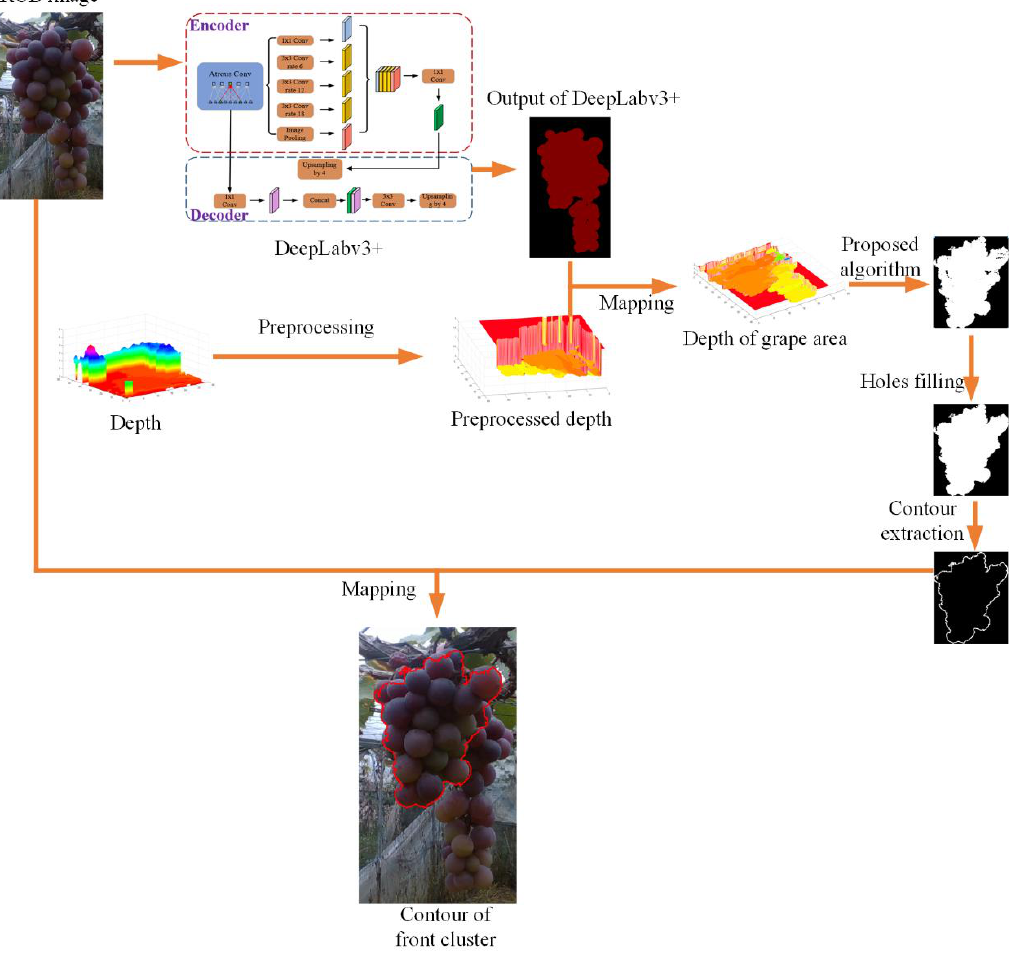
Figure 4. The sketch of the proposed method.